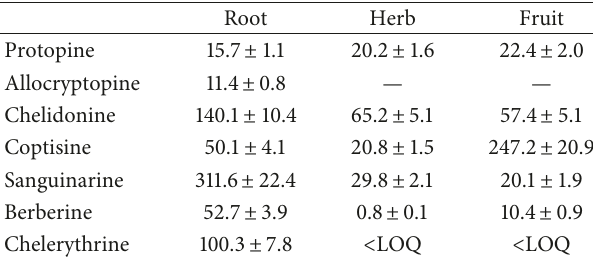
Table 4: The content of investigated alkaloids (mg/100g ± SD) in different parts of C. majus .